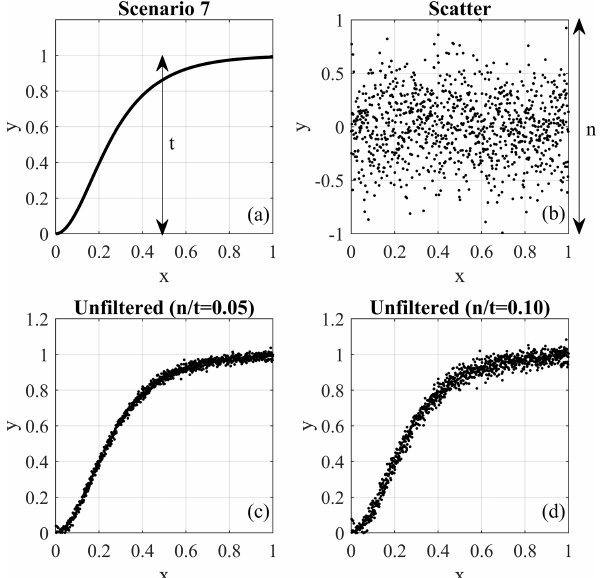
Figure 2. The procedure of generating a scenario with scatter: (a) generated scenario trend, (b) randomly generated scatter, and two scenarios with scatter based on n/t values of (c) 0.05 and (d) 0.10.